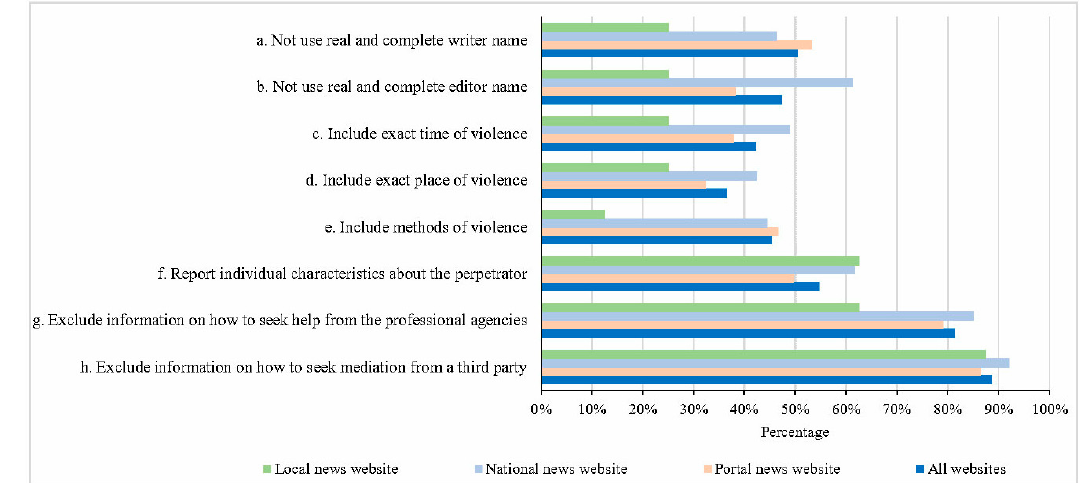
Figure 2. Percentage of media reports about violence against medical care providers adhering to professional recommendations (%).